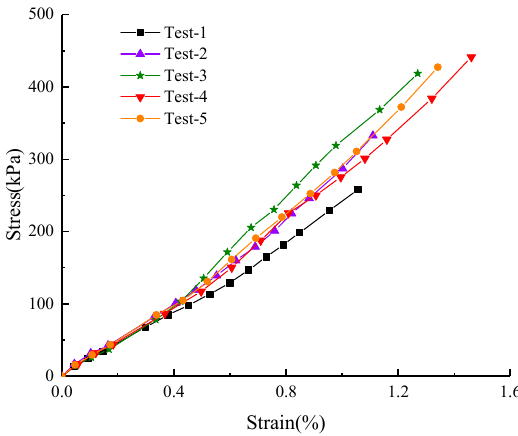
Figure 8. Curve of stress–strain of the soil between piles.